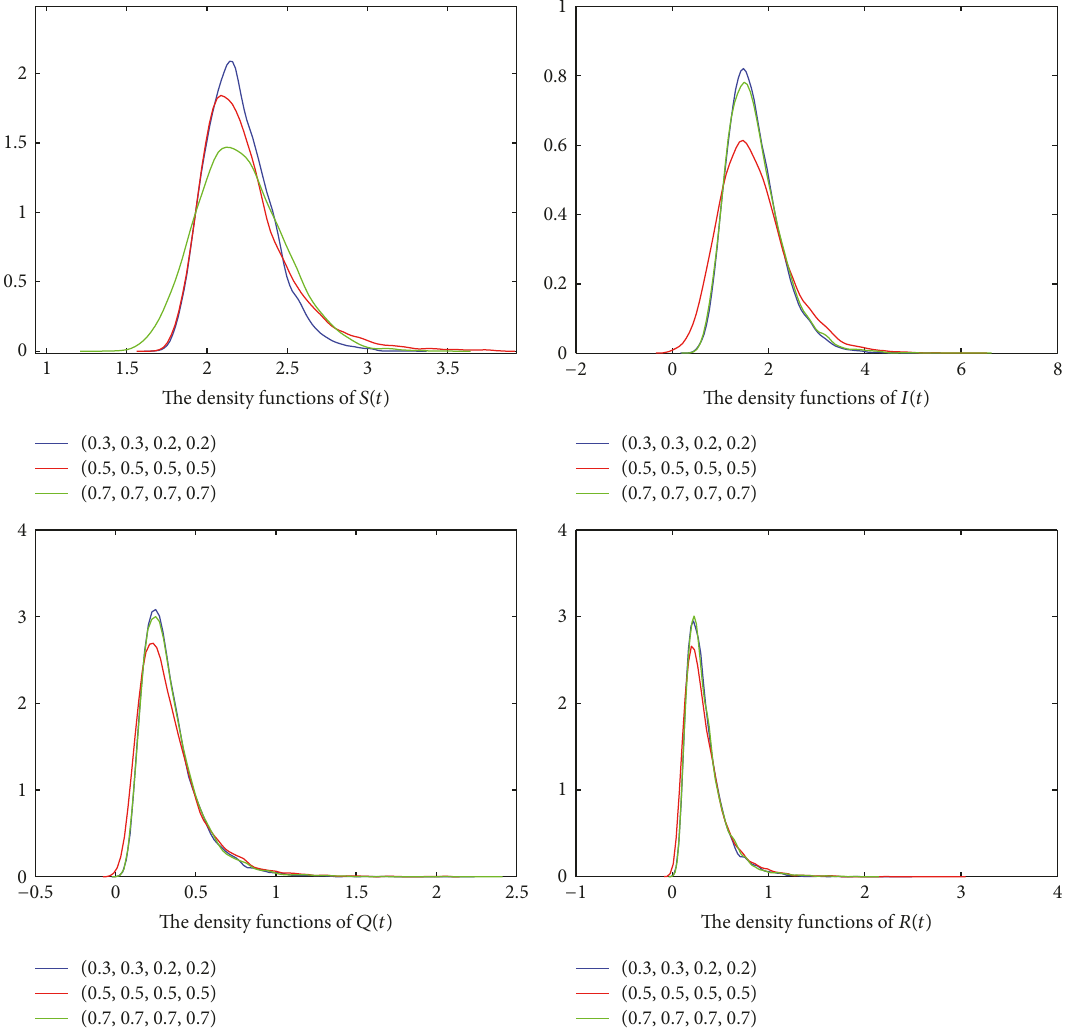
Figure 1: Based on the 10000 sample paths, after iterating 10,000 times, we get the density functions of 𝑆(𝑡), 𝐼(𝑡), 𝑅(𝑡) and 𝑄(𝑡) with different initial values. Here Δ𝑡 = 0.01